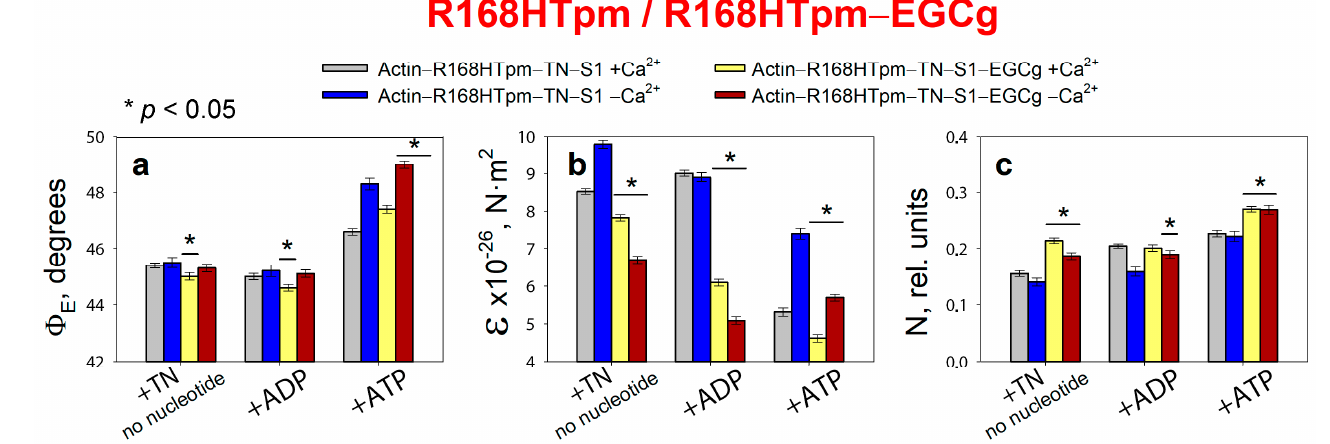
Figure 7. Effect of 30 μ M epigallocatechin-3-gallate (EGCg) on the values of Φ E ( a ), ɛ ( b ), and N ( c ) of polarized fluorescence of S1-AEDANS in the presence of R168HTpm. The changes are revealed in ghost muscle fibers under conditions simulating the sequential steps of the actomyosin ATPase cycle. The fluorescence parameters presented here are compared with the data obtained in the same experiment when the muscle fibers containing the R168HTpm without EGCg were used as a control. The data are presented as mean ± SEM. * p < 0.05 = difference between R168HTpm and R168HTpm–EGCg.